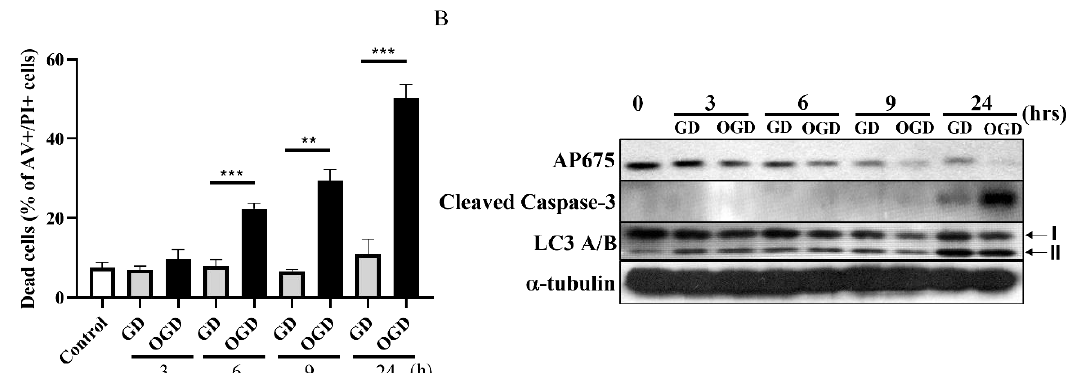
Figure 4. Downregulation of Tmem29 protein upon OGD in Neuro2a cells. ( A ) Significant cell loss was obtained after 6, 9, and 24 h of OGD insults; ( B ) Representative protein expression analysis by Western blot revealed a progressive decrease in Tmem29 protein expression by GD and OGD insult. The protein expression was lost at 24 h time point with a high abundance of cleaved caspase-3. Cultures responded to low glucose content with active autophagic marker LC3A/B expressed in both GD and OGD with highest expression at 24 h time points. Values were expressed as mean ± SD from 3 independent experiments with each sample done in triplicate. ** p < 0.01; *** p < 0.001.